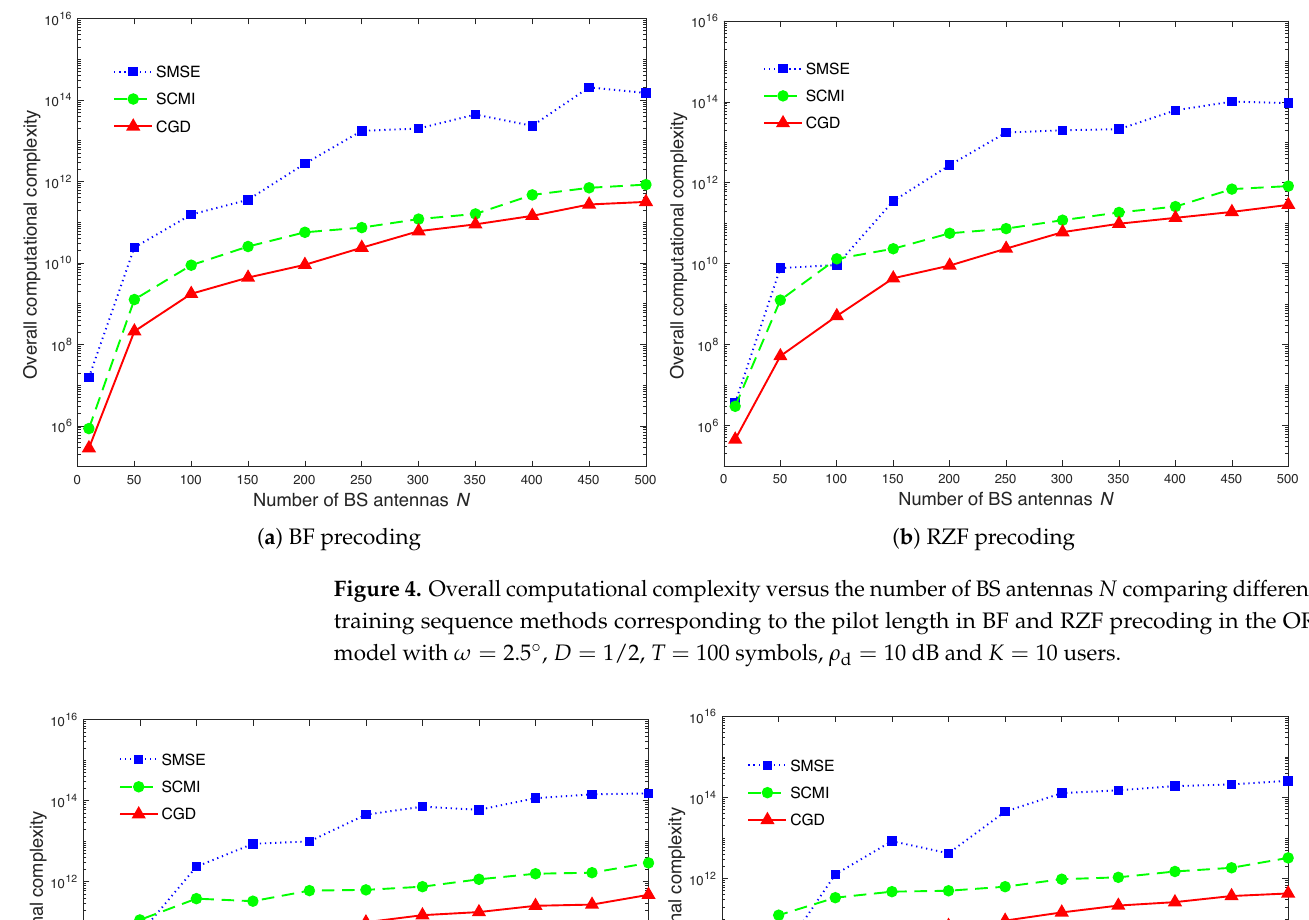
Figure 4. Overall computational complexity versus the number of BS antennas N comparing different training sequence methods corresponding to the pilot length in BF and RZF precoding in the OR model with ω = 2.5 ◦ , D = 1/2, T = 100 symbols, ρ d = 10 dB and K = 10 users.